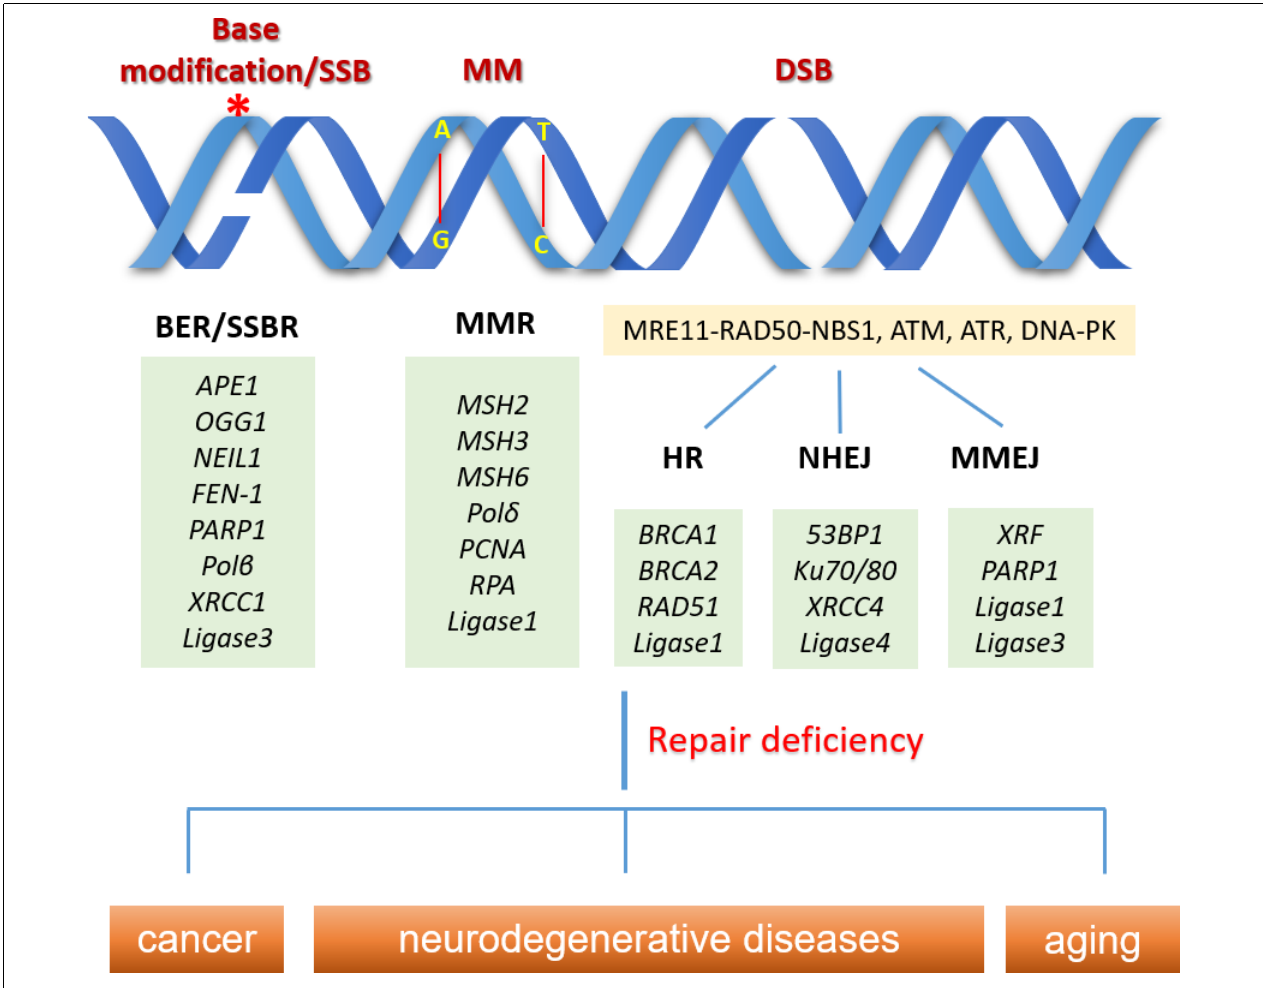
FIGURE 1 | Schematic overview of common DNA damage types and their repair pathways in normal physiology. DNA base modification (e.g., 8-oxo-7, 8-dihydroguanine) can be repaired by base excision repair (BER) initiated with the removal of the oxidized base by specific DNA glycosylases, leading to the generation of single-strand break (SSB), which are eventually resolved by SSB repair (SSBR) pathway involving DNA polymerase β and DNA ligase 3. DNA mismatches (MM) are repaired through the mismatch repair (MMR) pathway. MM can be recognized by a group of very conserved MutS homologs (e.g., MSH2, MSH3, and MSH6), and the DNA altered region is eventually replaced through the action of DNA polymerase δ and DNA ligase 1. Double strand breaks (DSBs) are sensed by MRE11-RAD50-NBS1, ATM, ATR, DNA-PK, while cells can choose different pathways (homologous recombination (HR), nonhomologous end joining (NHEJ), or microhomology-mediated end joining (MMEJ)) to repair the breaks, based on the cell types, cell phases and the structure of the DNA break ends. DNA repair deficiency is linked to human diseases like cancer and neurodegeneration, as well as aging. *Indicates the base modification of